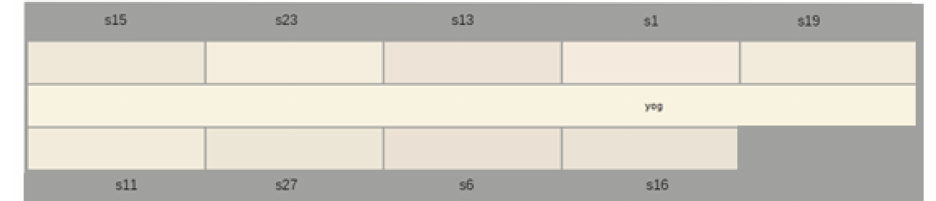
Figure 2. Impact of different extracts on the shade of yogurt in comparison with plain yogurt. The hues are as obtained by the colorimeter.